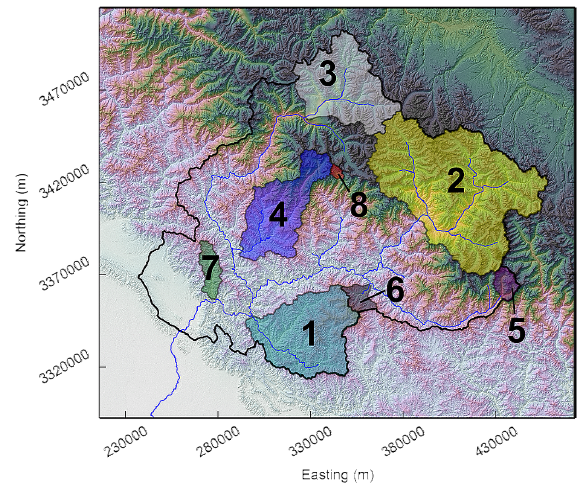
Figure 7. Location of sub-catchments used to determine the vari- ability in production rate across the Ganga catchment (presented in Table